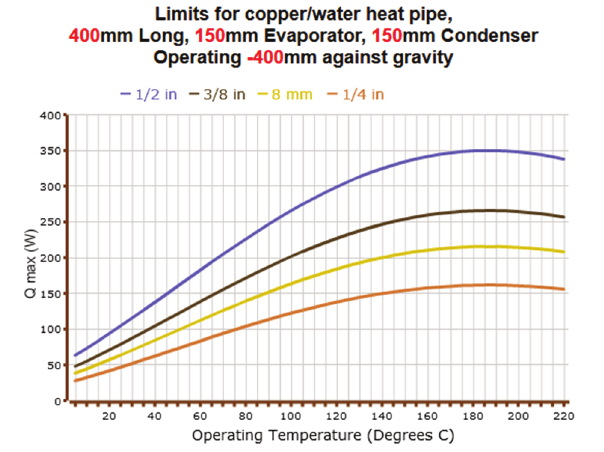
Fig. 4. Curve Q max = f(operating temperature) for a water heat pipe [22]